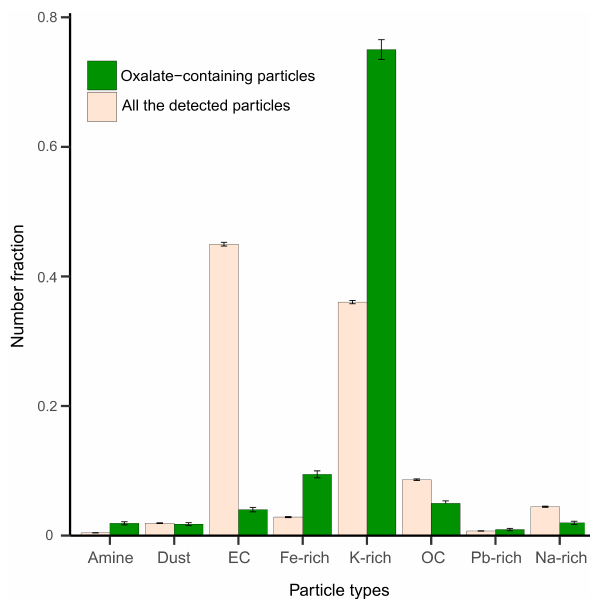
Figure 4. Number fractions of the single particle types for oxalate- containing and all the detected particles.